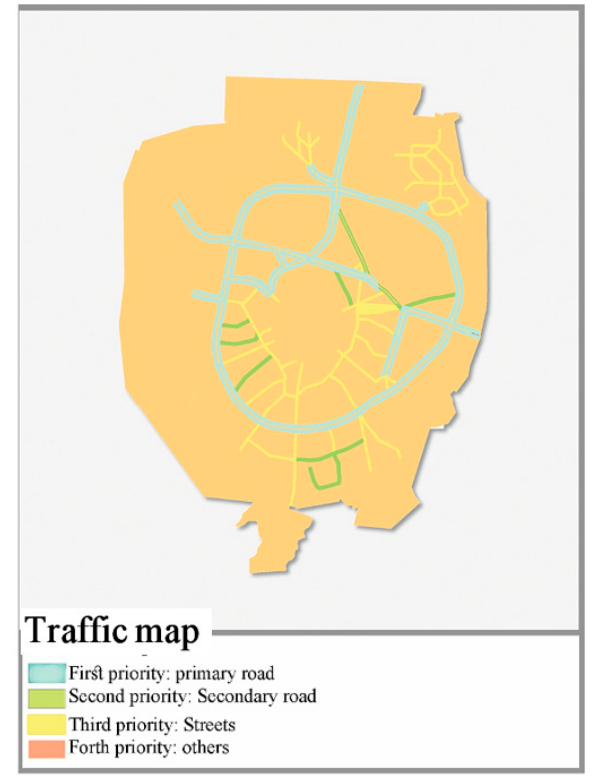
Figure 11. The traffic map of Hamedan based on the sub-criteria measures in Table 1.